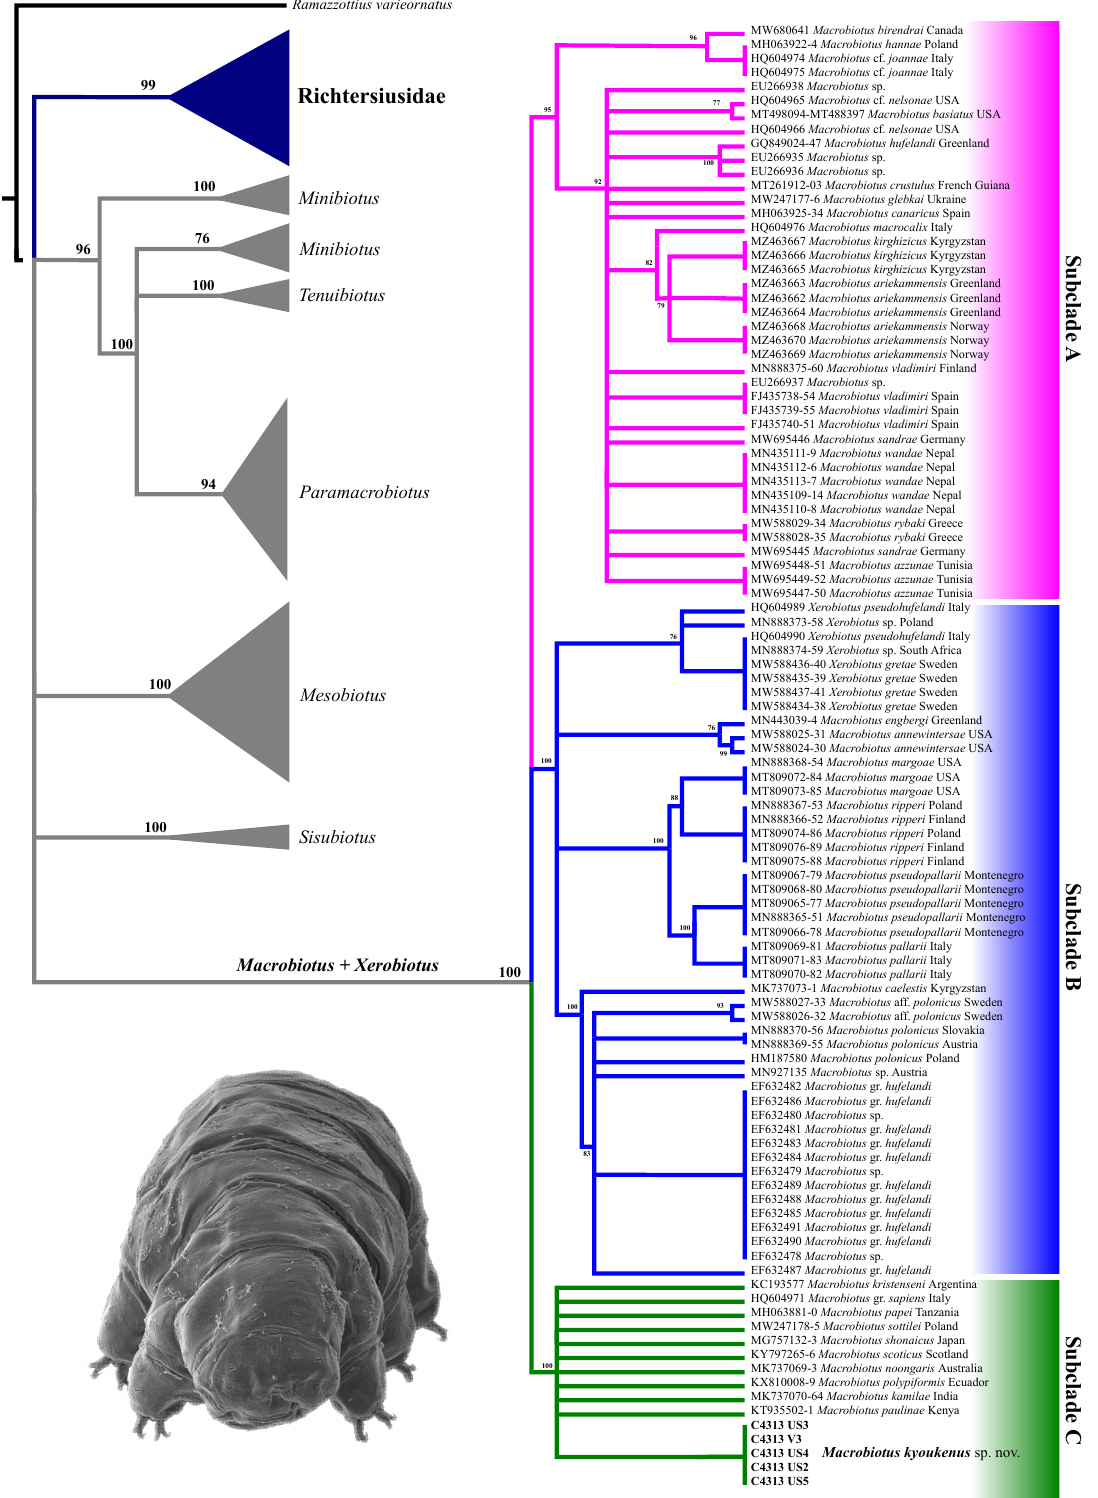
Figure 5. Maximum likelihood phylogenetic tree based on 3659 bp of the 18S and 28S rRNA genes in specimens pertaining to the superfamily Macrobiotoidea. Values in bold denote bootstrap values. All nodes with bootstrap <70% are collapsed. Specimens newly analysed for the present paper are shown in bold; ( lower left ) In toto specimen of M. kyoukenus sp. nov.